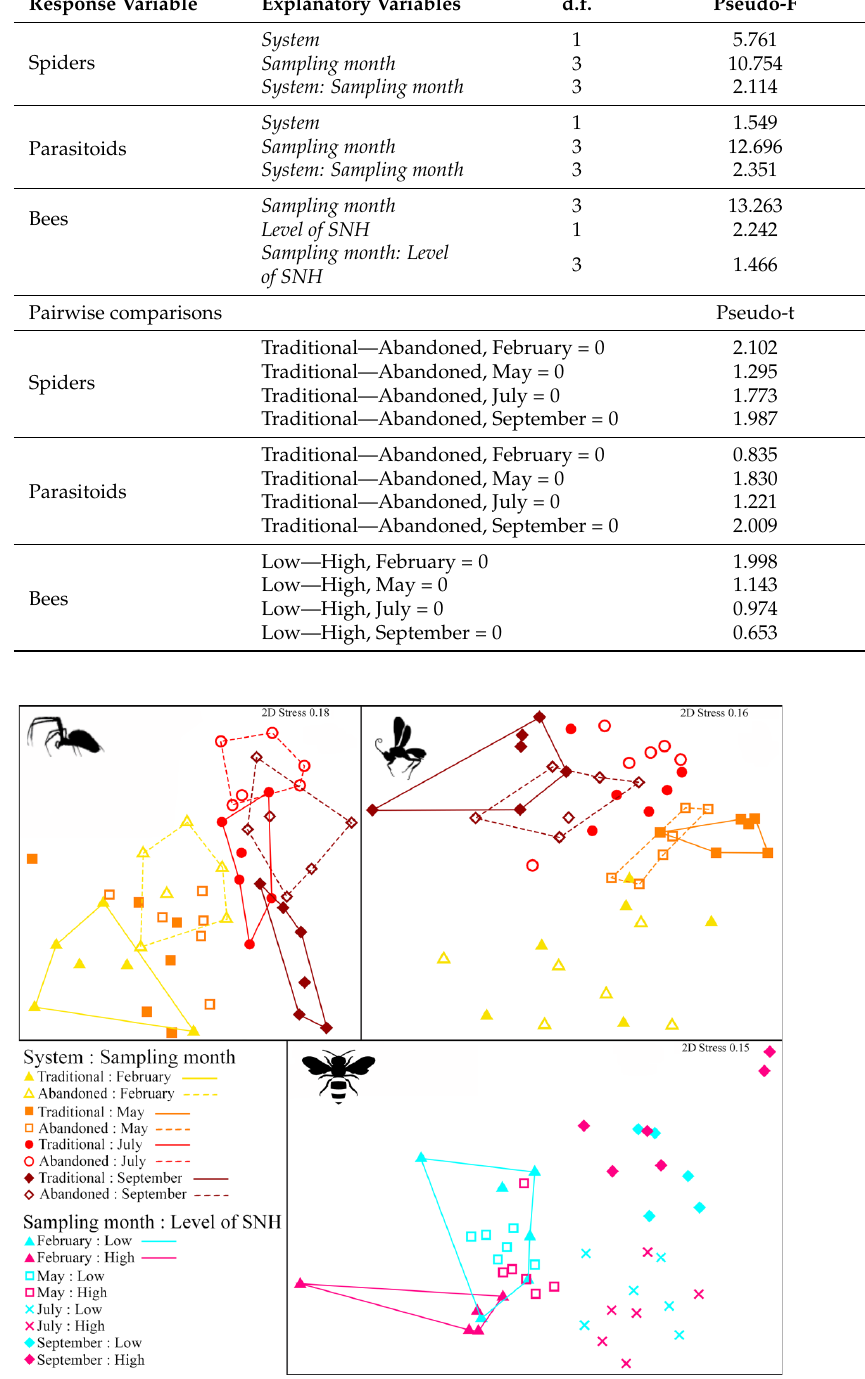
Figure 3. MDS for the spider, parasitoid, and bee communities sampled (Bray – Curtis index, square- root – transformed abundances). Polygons include the samples belonging to the same category of the variable system or level of semi-natural habitats for each sampling period. Only polygons for which significant pairwise comparisons were detected in the PERMANOVA are represented. SNH = semi- natural